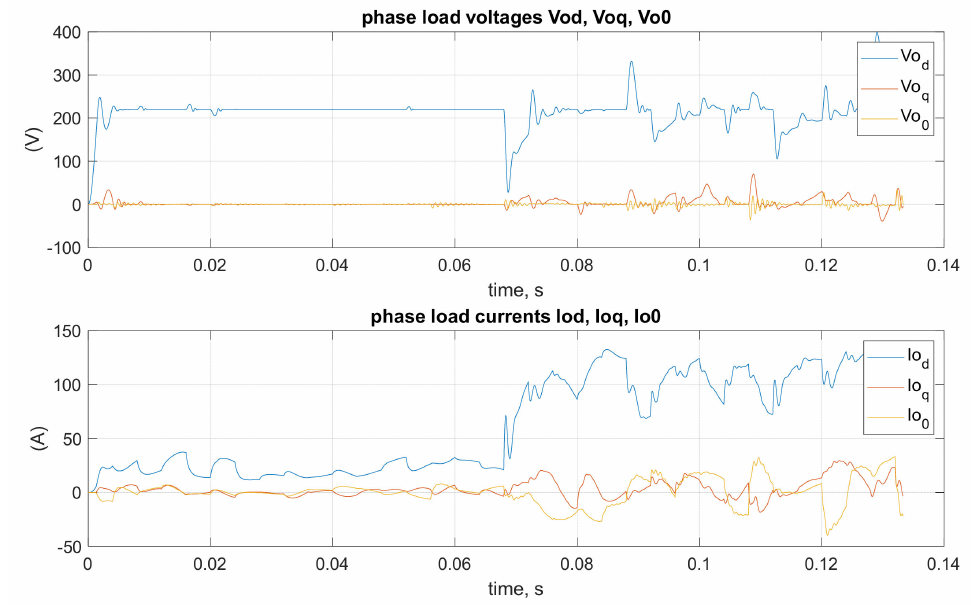
Figure 17. Load voltage V o during a steep increase in load current I 0 at the time of 0.068 s in the dq coordinate